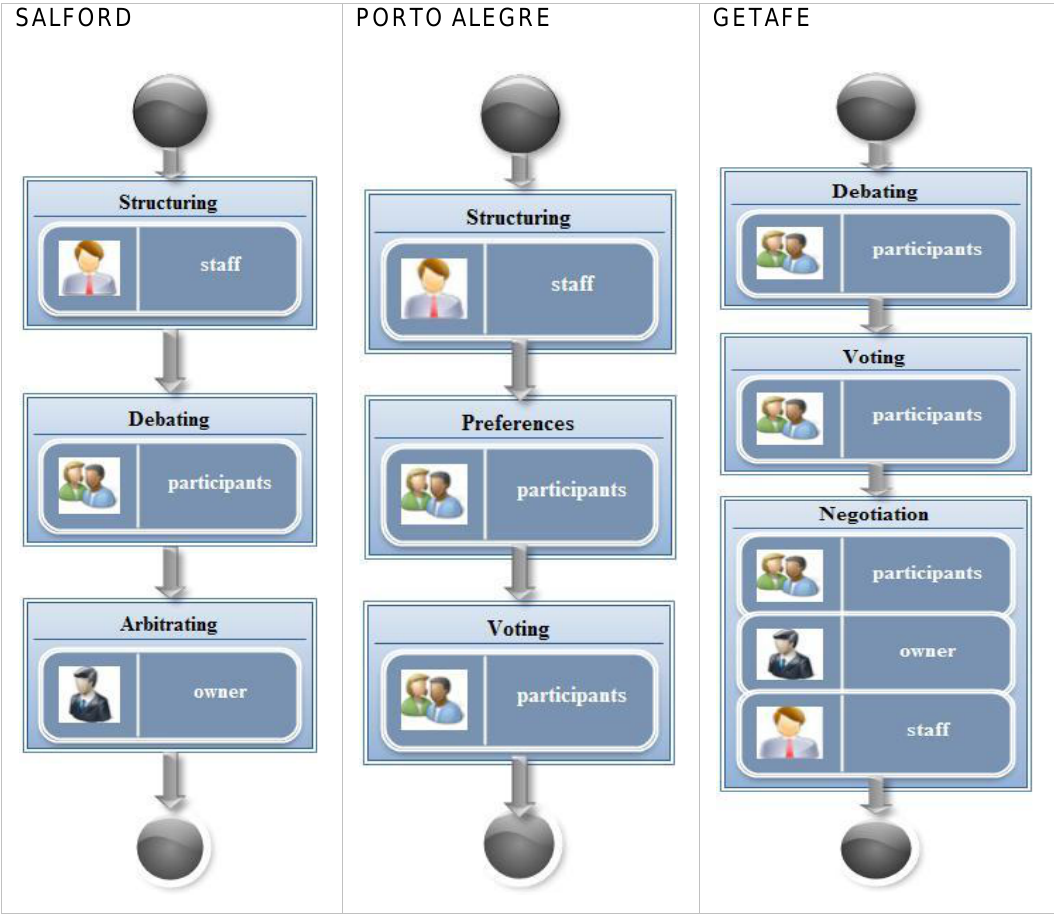
Figure 1: Salford, Porto Alegre and Getafe PB